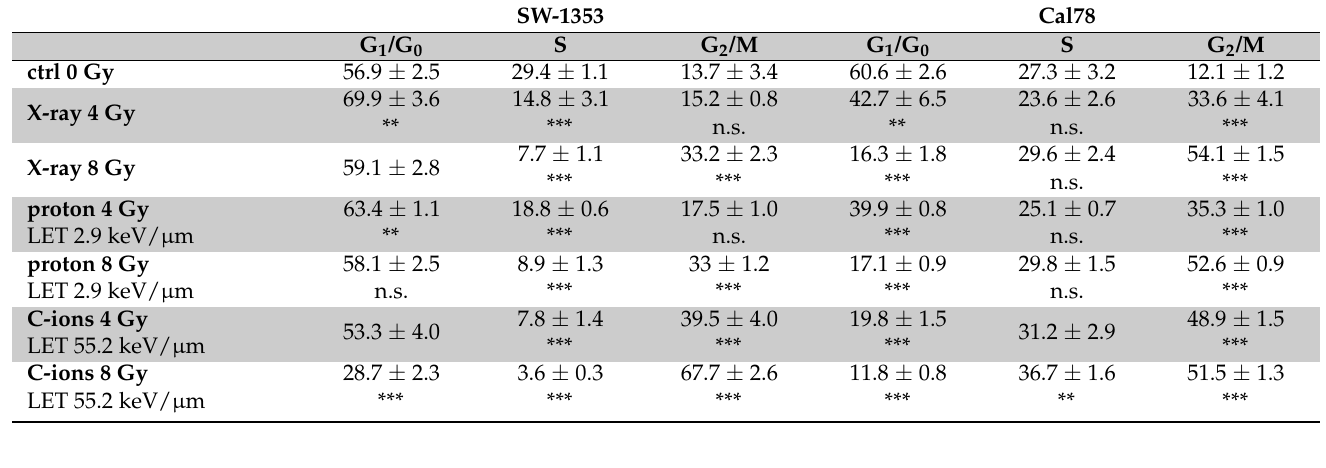
Table 1. Cell cycle distribution of chondrosarcoma cells 24 h after 4 and 8 Gy photon (X-ray)/proton/C-ions IR ( n = 4; mean ± SD; ** p < 0.01; *** p < 0.001; n.s.: not significant). SW-1353 Cal78 G 1 /G 0